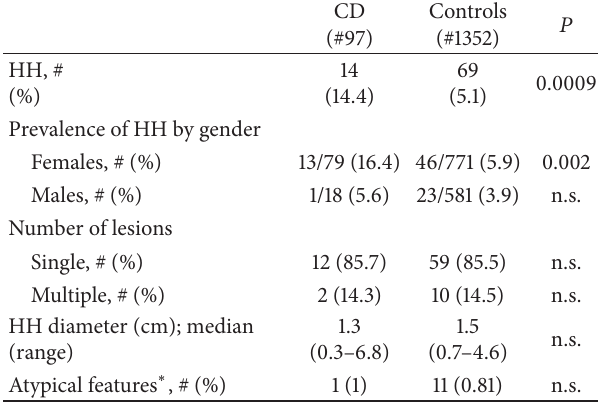
Table 2: Characteristics of US findings in celiac disease (CD) patients and in controls.